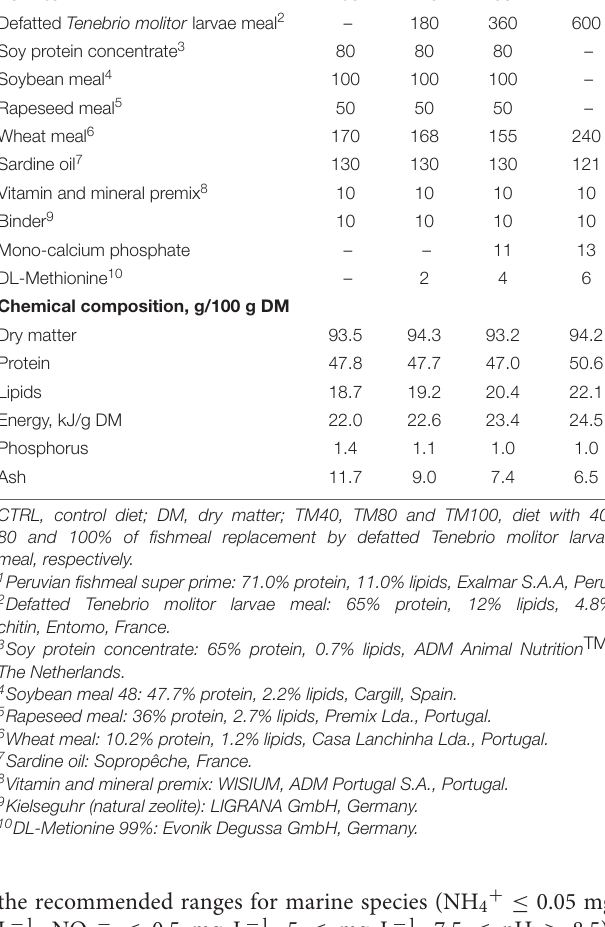
TABLE 2 | Fatty acid profile of the experimental diets. TABLE 1 | Ingredients and chemical composition of the experimental diets. CTRL TM40 TM80 TM100 CTRL TM40 TM80 TM100 Fatty acids, g/100 g